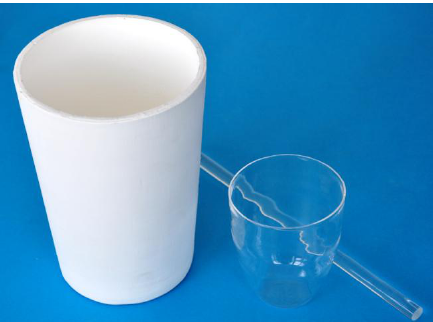
Figure 6. Crucibles applied in the glass melting processes: 1100 cm 3 in volume made of ground and sintered quartz glass; 200 cm 3 in volume made of clear quartz glass; 10 mm in diameter quartz glass rod used for glass melt